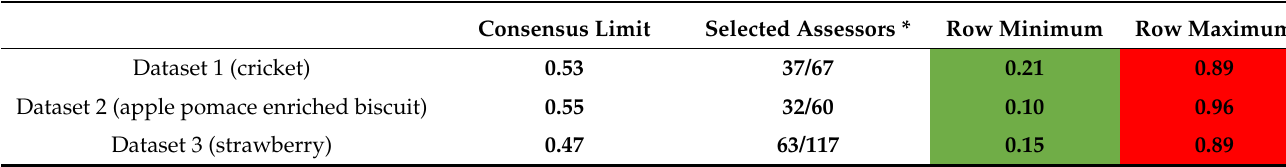
Figure 2. Excerpts from the three heatmaps for the three case studies ( A : Cricket, B : Apple pomace enriched and C : Strawberry). Red color means lower, while green color means better discrimination ability. Sample names are in the first columns, while participants are denoted by numbers. Table 3. Summary of the average similarity values and row minimum and maximum values for the heatmaps in each case